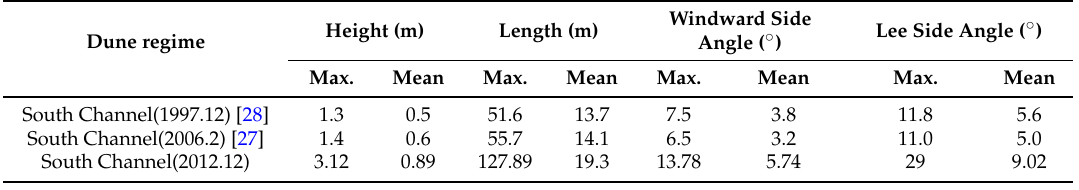
Table 3. Statistical characteristic of dunes in the South Channel of the Yangtze River estuary.